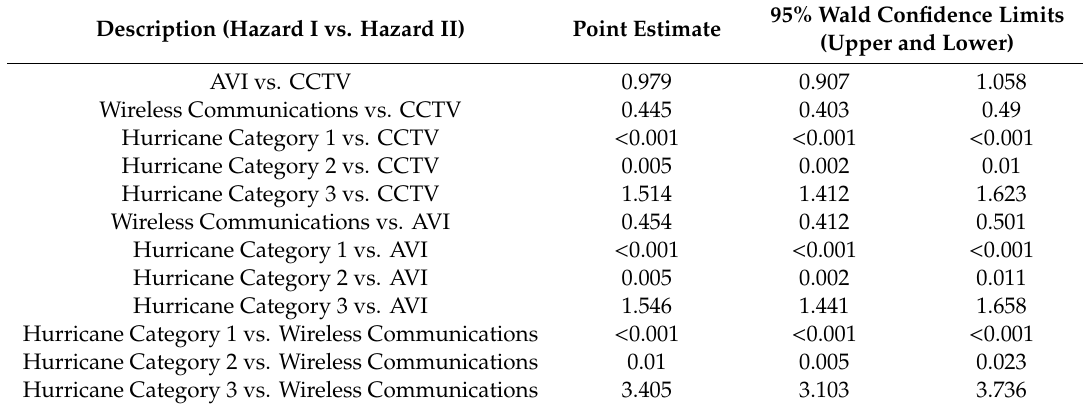
Table 4. Pairwise: hazard ratios for failure (vehicle detection components).